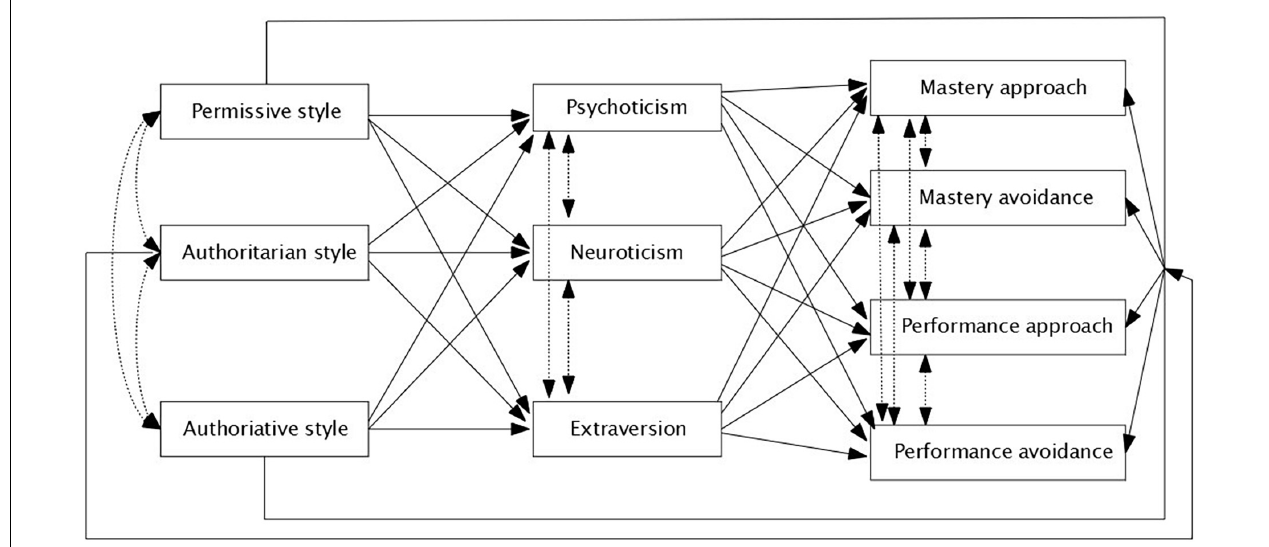
FIGURE 1 | Theoretical tested model on dimensions of parenting styles, personality traits, and achievement